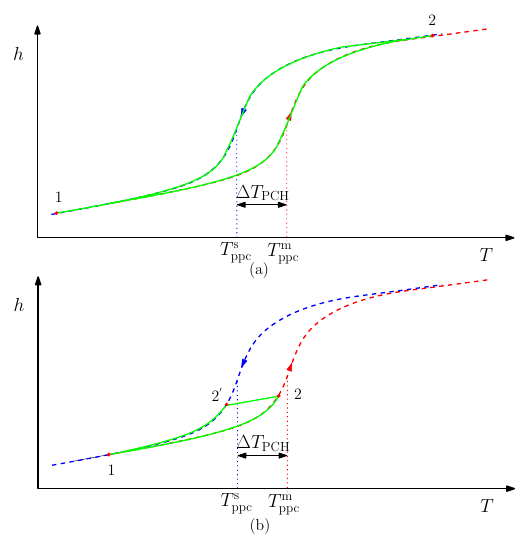
Fig. 1. The h-T dependency during a (a) complete phase change and (b) partial phase change